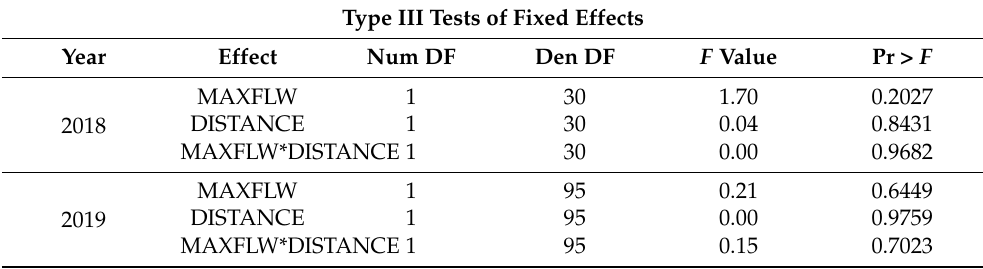
Table A18. The effect of maximum flower number and interplant distance on fruit set at Shinob Kibe in 2018 and 2019.